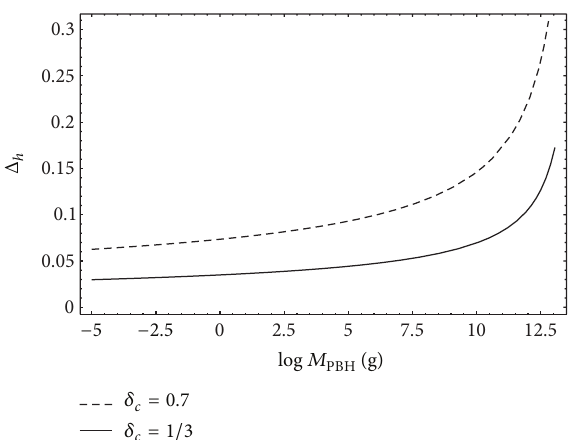
Figure 1: The dependence of the r.m.s. perturbation Δ ℎ at the mass required for the explanations of dark matter as PBHs scale 𝑀 PBH remnants in dependence on the initial PBH’s mass 𝑀 the collapse threshold 𝛿 𝑐 = 1/3 (solid curve) and 𝛿 𝑐 ≃ 0.7 (dashed